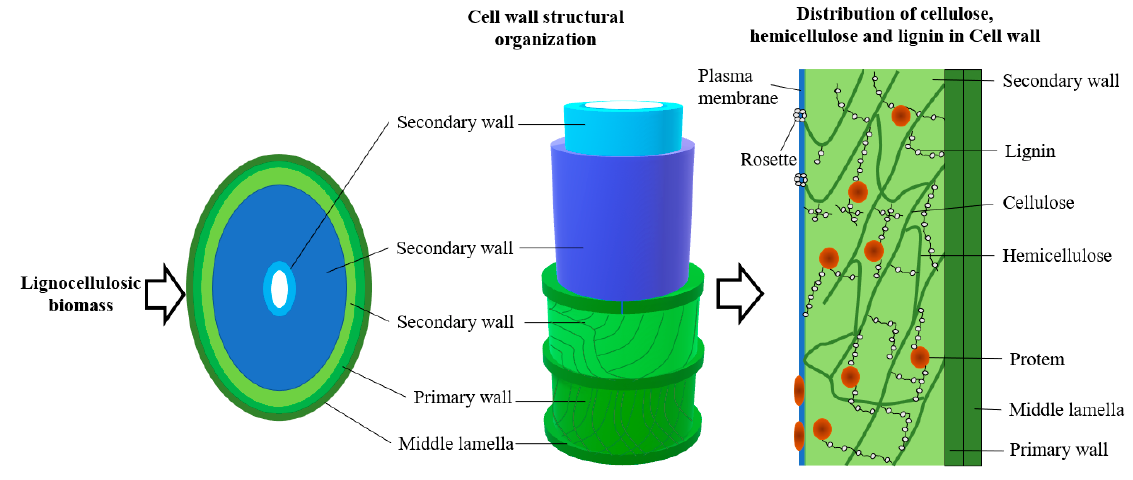
Figure 8. Composition of lignocelluloses.